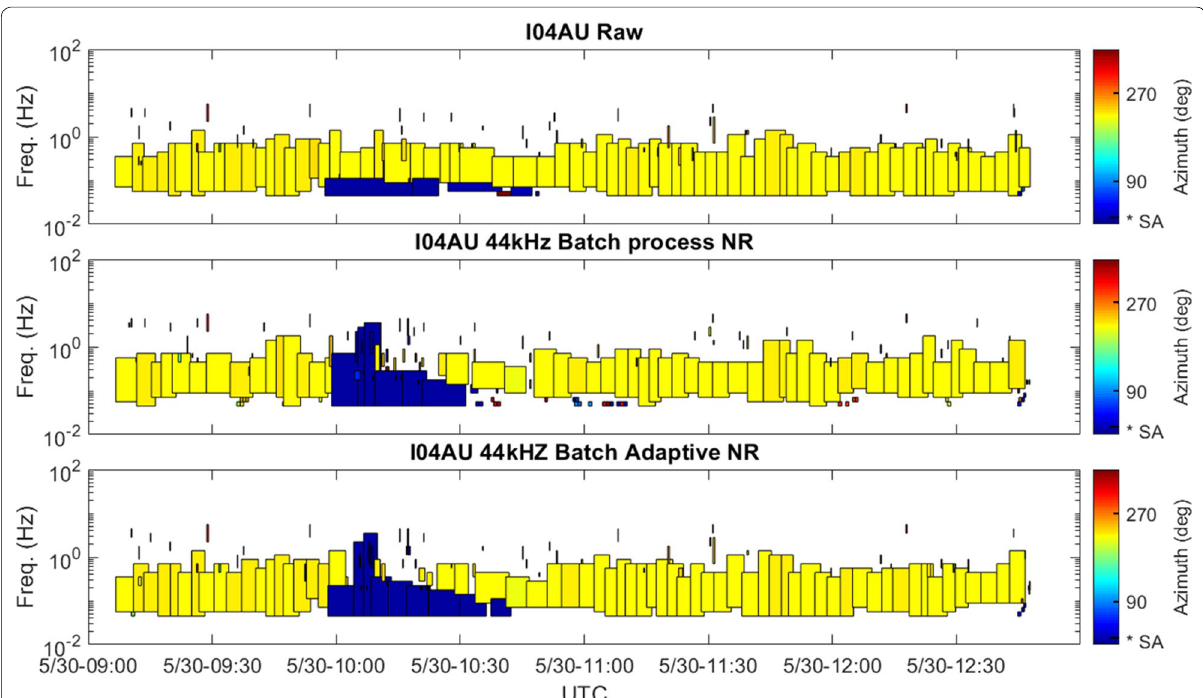
Fig. 6 Array processing results for I04AU. In this example a noise profile from a single sensor at the station was used for noise reduction processing of all channels (Batch process NR). Adaptive noise reduction, which does not require a preselected noise profile, was also used on all channels (Batch adaptive NR). The noise reduction software was configured with the same settings as was used for I06AU. Prior to processing, the signal is present only at frequencies lower than the microbarom whereas in the noise-reduced data the broader band characteristics of the signal are